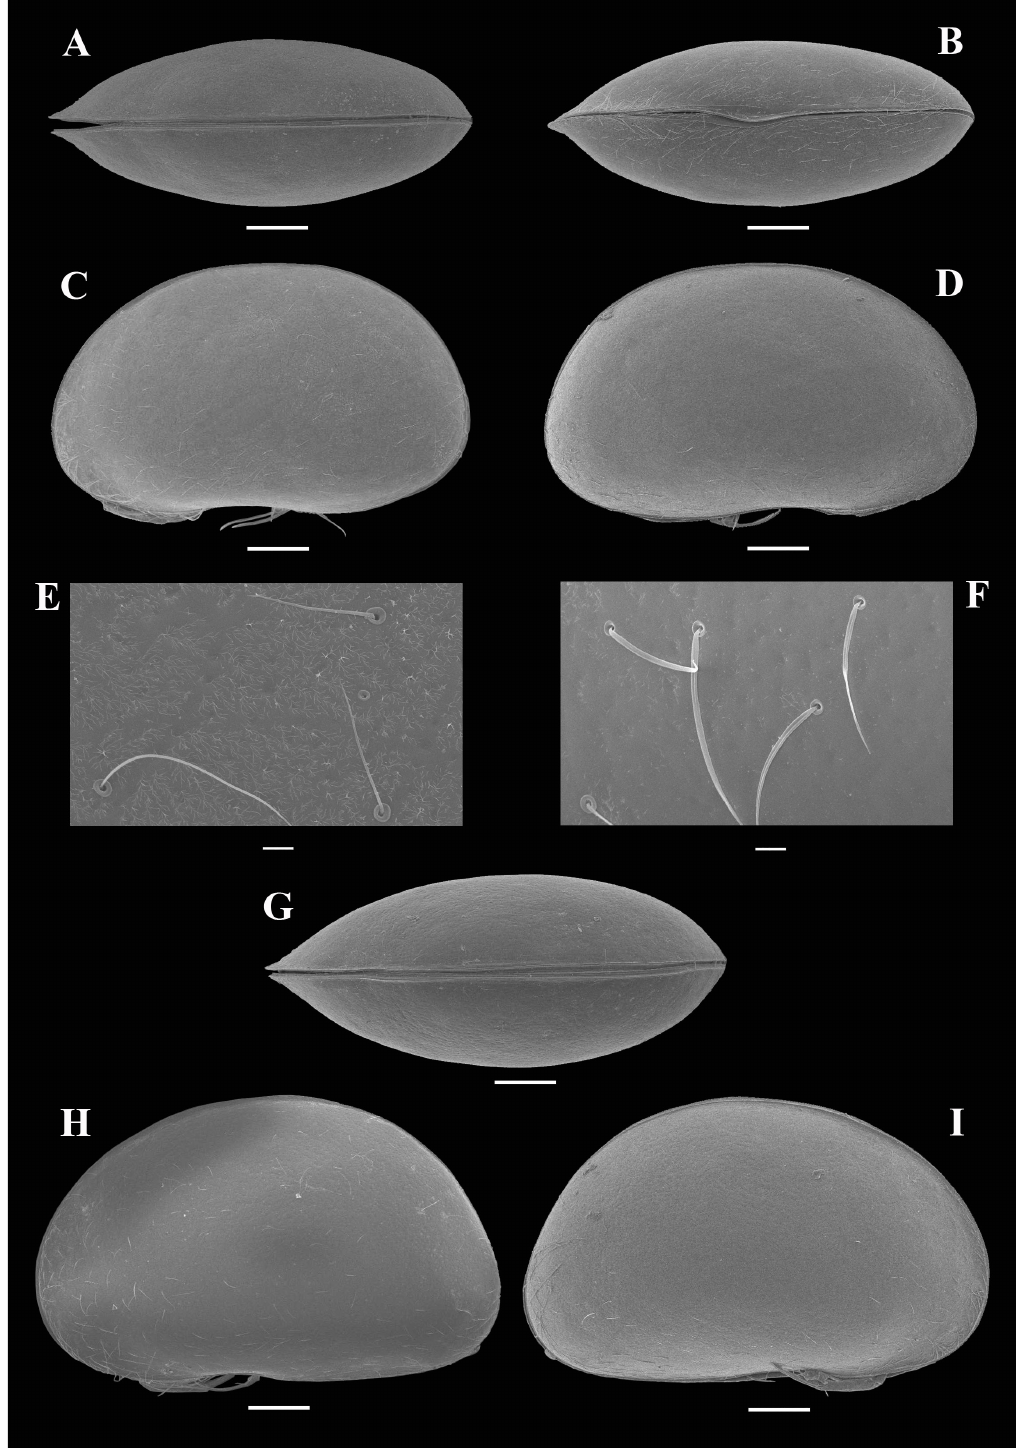
Fig. 1. Martensina thailandica gen. et sp. nov., paratypes. A–E . Males. F–I . Females. A . Cp, dorsal view (MSU-ZOC.321). B . Cp, ventral view (MSU-ZOC.324). C . Cp, left lateral view (MSU-ZOC.322). D . Cp, right lateral view (ditto). E . Cp, left lateral view, valve surface (ditto). F . Cp, left lateral view, valve surface (MSU-ZOC.330). G . Cp, dorsal view (MSU-ZOC.329). H . Cp, left lateral view (MSU- ZOC.330). I . Cp, right lateral view (ditto). Scale bars: A–D, G–I = 200 μm; E–F = 10